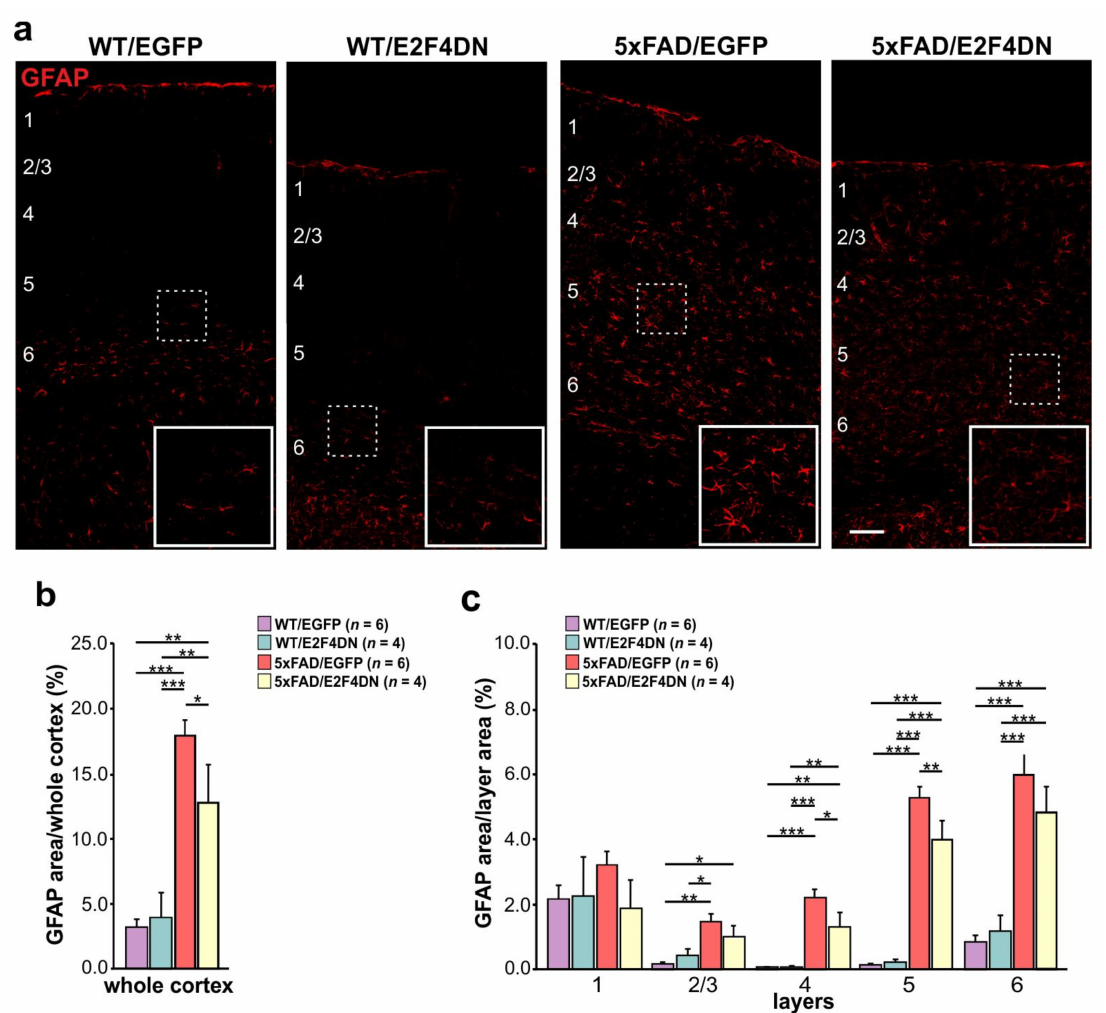
Figure 5. Modulation of astrogliosis by E2F4DN in the cerebral cortex of 1-year-old 5xFAD mice. ( a ) GFAP immunostaining in the cerebral cortex of mice with the indicated genotypes. Numbers refer to the different cortical layers (identified by DAPI staining; not shown). Inserts show the high magnifications of the indicated dashed boxes. ( b ) Percentage of the area occupied by GFAP immunostaining in the cerebral cortex. ( c ) Percentages of the area occupied by GFAP immunostaining in the cortical layers. * p < 0.05; ** p < 0.01; *** p < 0.001 (one-way ANOVA followed by post hoc Newman-Keuls test). Scale bar: 100 µ